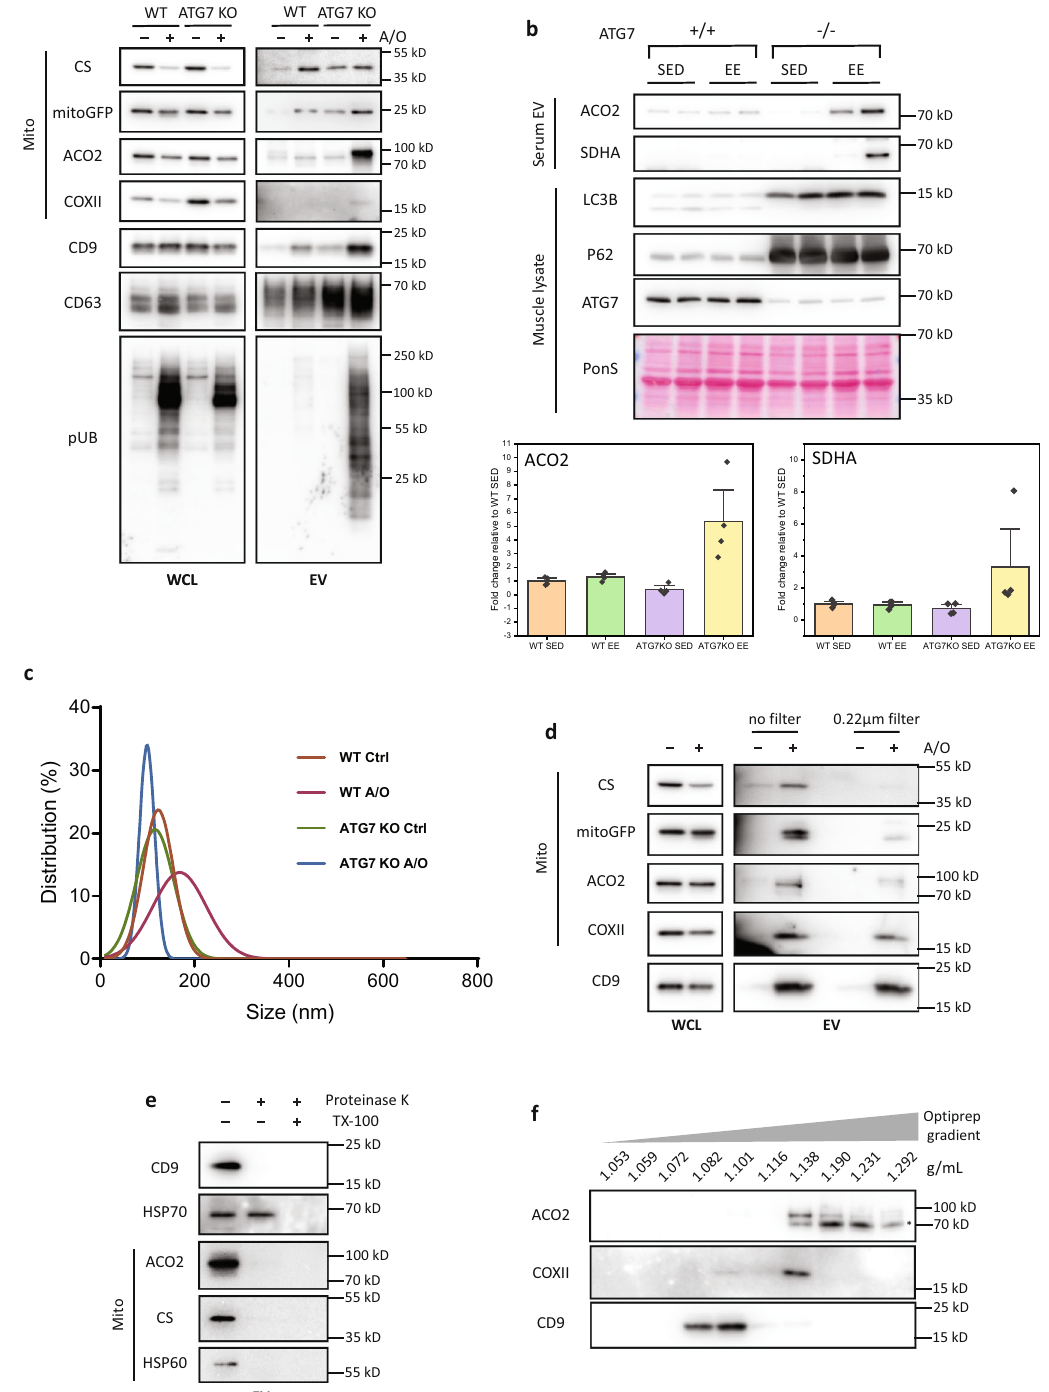
Fig. 4 Damaged mitochondria are secreted via a pathway distinct from small EVs. a Conditioned media from WT and ATG7-KO HeLa stably expressing mCherry-Parkin treated with A/O for 24 h were collected. Extracellular vesicles (EVs) were isolated by differential ultracentrifugation and immunoblotted for mitochondria and small EV markers. b Control or muscle speci fi c ATG7-KO ( Atg7 f/f ;Ckmm-cre ) mice were subjected to 3 consecutive days of exhaustive exercise. Serum EVs or TA muscle tissue were then harvested. Representative immunoblots and quanti fi cation of the mitochondria markers (ACO2 and SDHA) from serum EVs are shown. Mean of n = 4 mice per group ±SEM. c Nanoparticle tracking analysis of EVs from WT and ATG7-KO cells untreated or treated with A/O for 24 h. d Conditioned media from 24 h A/O treated ATG7-KO HeLa stably expressing mCherry-Parkin were fi ltered (0.22 µ m cutoff) before isolation of EVs by differential ultracentrifugation and immunoblotting. e Proteinase K protection assay of EVs isolated by differential ultracentrifugation from 24 h A/O treated ATG7-KO HeLa stably expressing mCherry-Parkin. f EVs from 24 h A/O treated ATG7-KO cells were separated by a 5 – 40% bottom-up iodixanol density fl otation gradient and subjected to immunoblotting. *Non-speci fi c